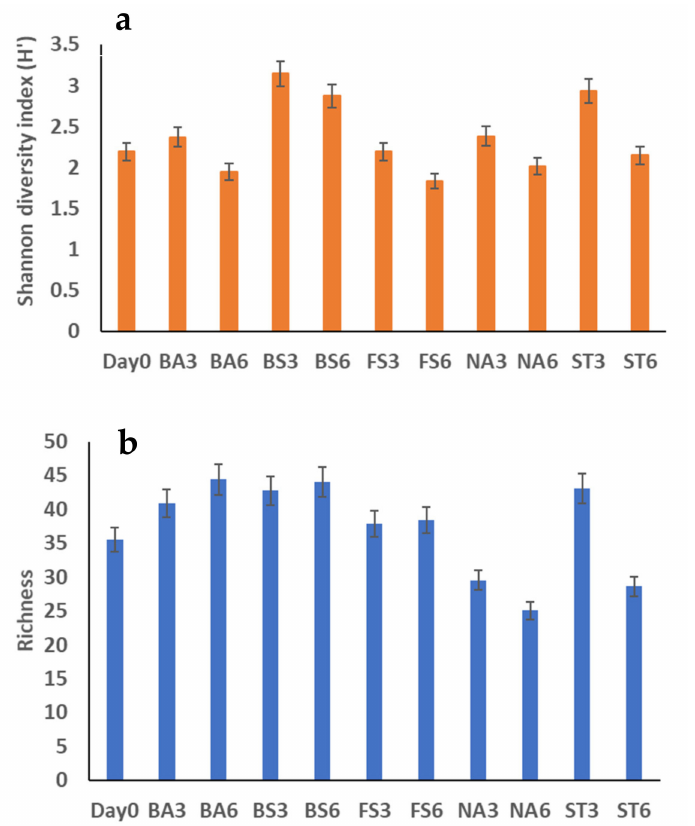
Figure 5. Bacterial diversity indices of samples for 6 weeks experiments. NA: Natural attenuation; FS: Fusarium solani ; BS: Biostimulation; BA: Bacilli, ST: Streptomyces ; 3, 6: weeks. ( a ) Shannon Diversity index (H’); ( b ) Richness.